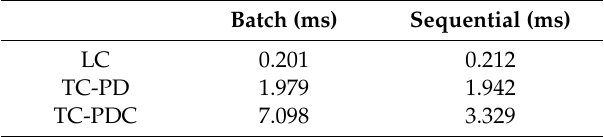
Figure 9. Computation times of measurement update for LC, TC-PD, and TC-PDC. Table 6. Mean value of computation times for LC, TC-PD, and TC-PDC.